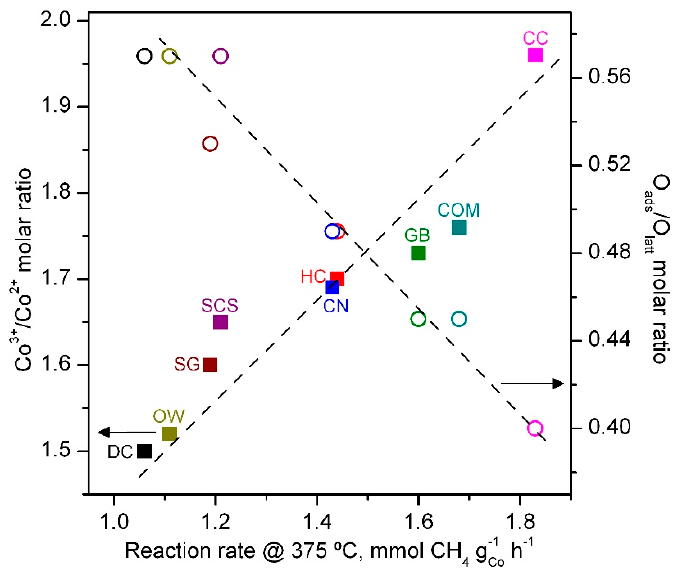
Figure 8. Relationship between reaction rate and the surface composition, in terms of Co 3+ /Co 2+ and O ads /O latt molar ratios, of the bulk Co 3 O 4 catalysts.